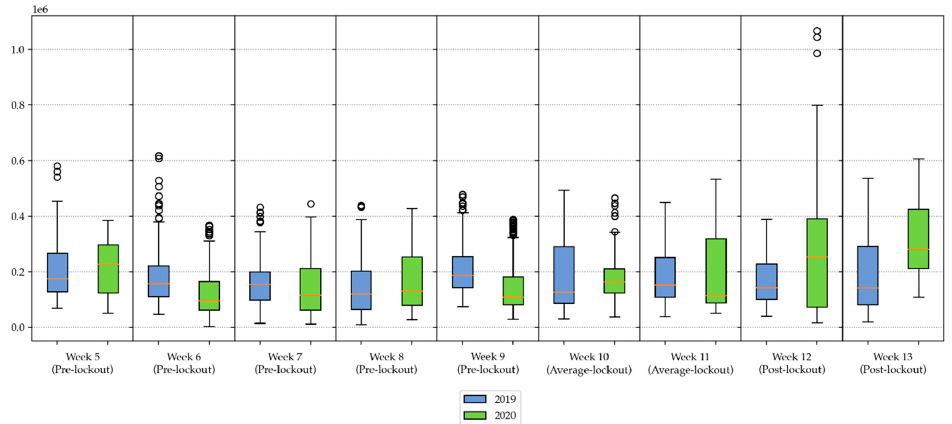
Figure 26. Statistical comparison between 2019 and 2020 Dispatching services market (MSD) costs. Shown quantities are relative to hourly MSD costs and are aggregated weekly.